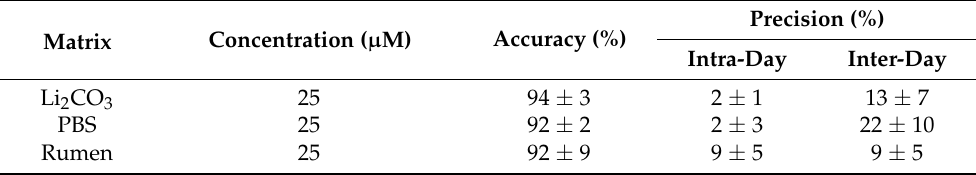
Table 3. Determined values of accuracy ( n = 6) and both intra-day ( n = 6) and inter-day ( n = 18) precision for Li 2 CO 3 buffer, phosphate buffered saline buffer, and rumen inoculum. Precision (%) Matrix Concentration ( µ M) Accuracy (%) Intra-Day Inter-Day Li 2 CO 3 25 94 ± 3 2 ± 1 13 ± 7 PBS 25 92 ± 2 2 ± 3 22 ± 10 Rumen 25 92 ± 9 9 ± 5 9 ±